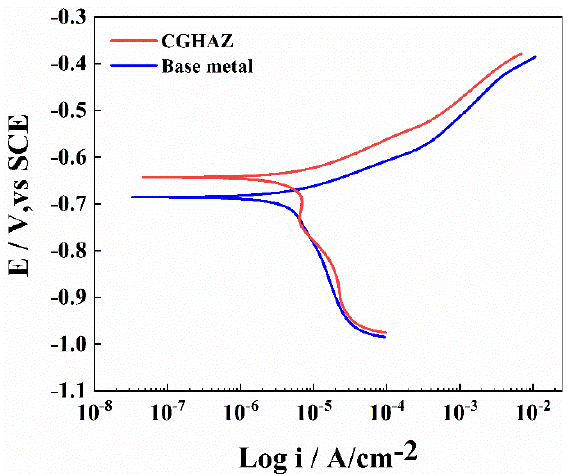
Figure 5. Potentiodynamic polarization curves of the base metal and CGHAZ (100 kJ/cm) of the tested steels in 3.5 wt.% NaCl solution. Table 4. Electrochemical corrosion parameters of the tested steels.